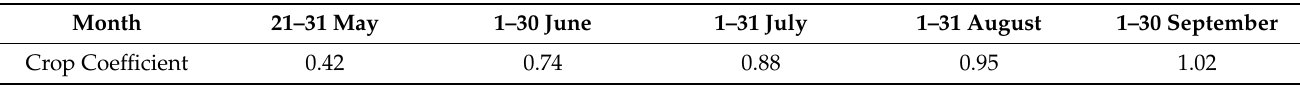
Table 1. Values of the crop coefficient for the Penman-Monteith formula for giant miscanthus cultivated in the Kuyavia region (own elaboration on the basis of ˙Zyromski et al.,